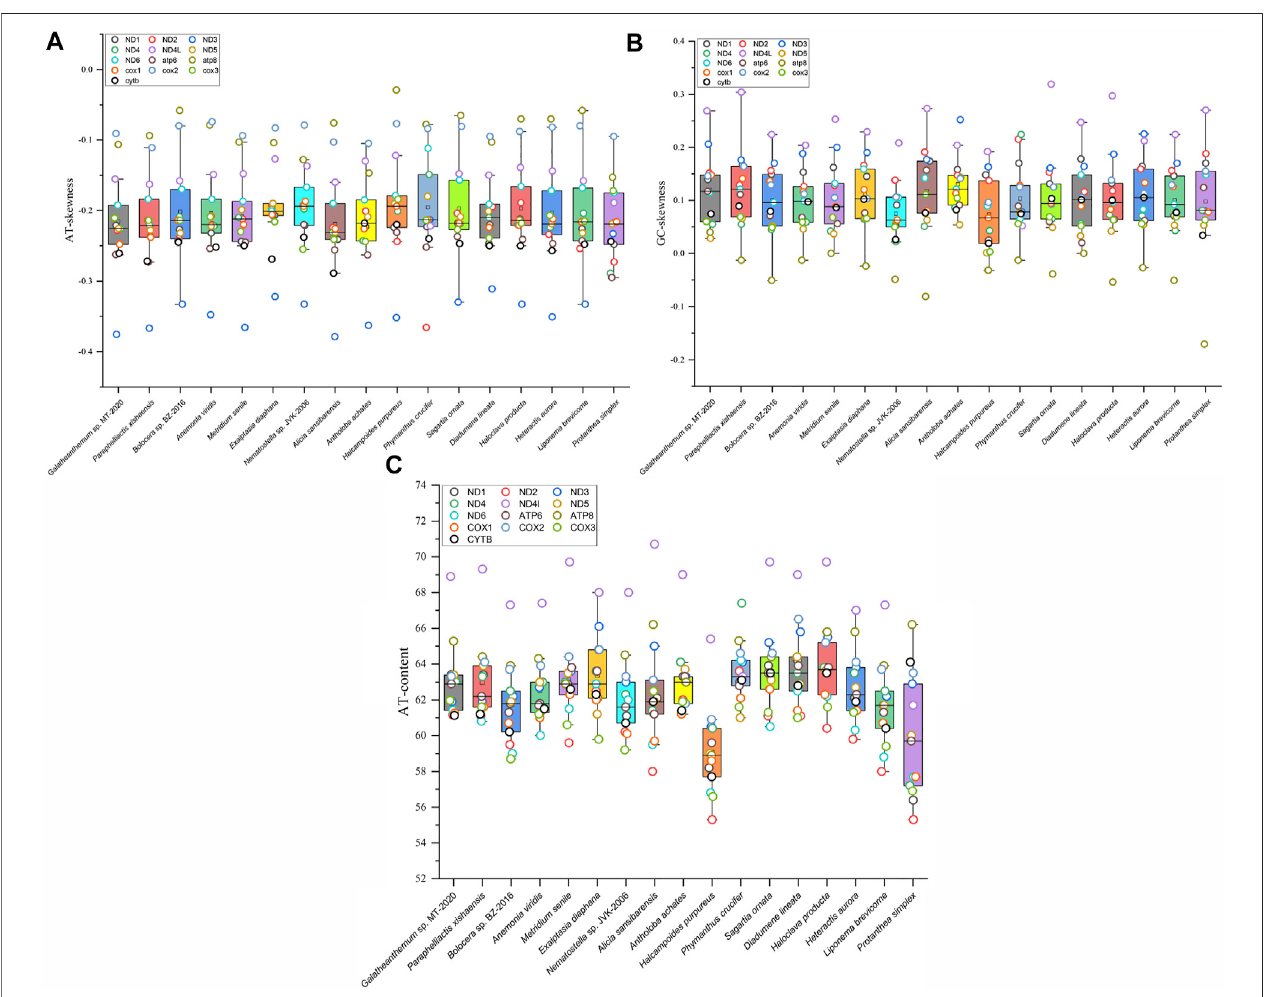
FIGURE 2 | Mitochondrial nucleotide composition of Actiniaria from different families. Box plots showed (A) the AT content, (B) GC skewness, and (C) AT skewness of 13 PCGs in mitochondrial genomes from 16 sea anemone species. PCG was represented by small circle in different colors.